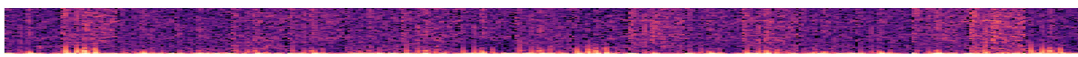
Figure 6. Example of STFT spectrogram image. STFT spectrogram images for each channel ‘FP1’, ‘FP2’, ‘F7’, ‘F3’, ‘FZ’, ‘F4’, ‘F8’, ‘T7’, ‘C3’, ‘CZ’, ‘C4’ ‘, ‘T8’, ‘P7’, ‘P3’, ‘PZ’, ‘P4’, ‘P8’, ‘O1’, ‘O2’ were merged in that order.